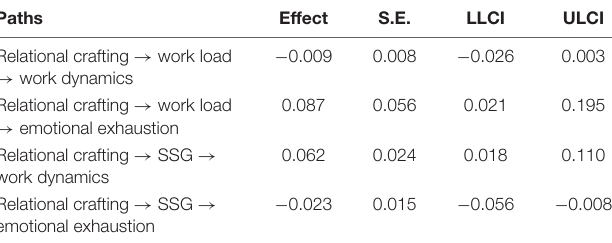
TABLE 3 | Results of bootstrapping mediation effect